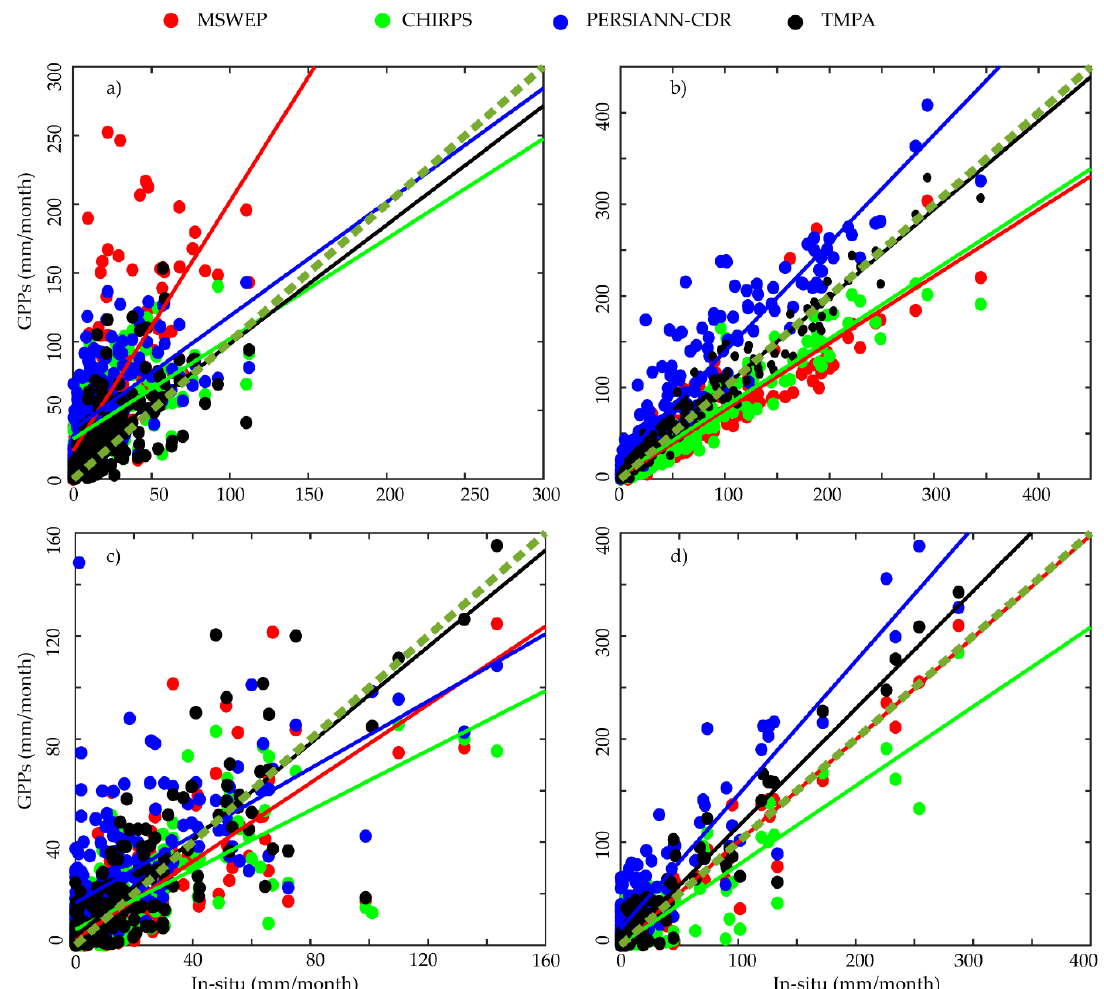
Figure 6. Scatterplots of monthly precipitation for in-situ and GPPs at selected locations. ( a – d ) are equivalent to regions 1, 2, 3 and 4 in Table 1.